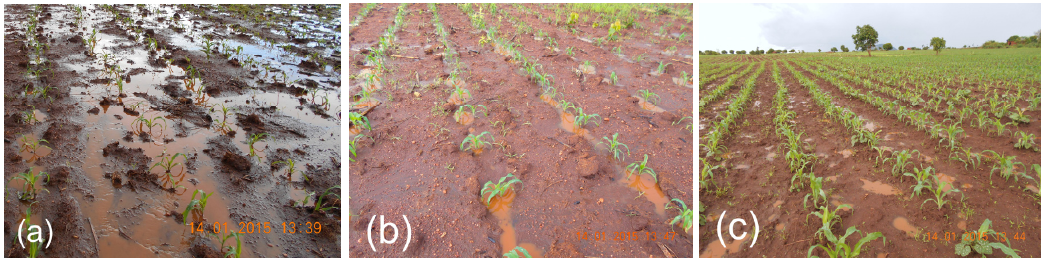
Figure 7. Example of water runoff between riplines ( a ); water puddles in riplines ( b ); and water puddles between plant rows without signs of runoff in a conventionally tilled field ( c ). The photos were taken 50 m and 5–8 min apart shortly after a rainstorm near Chipata (photo: K.B. Esser).